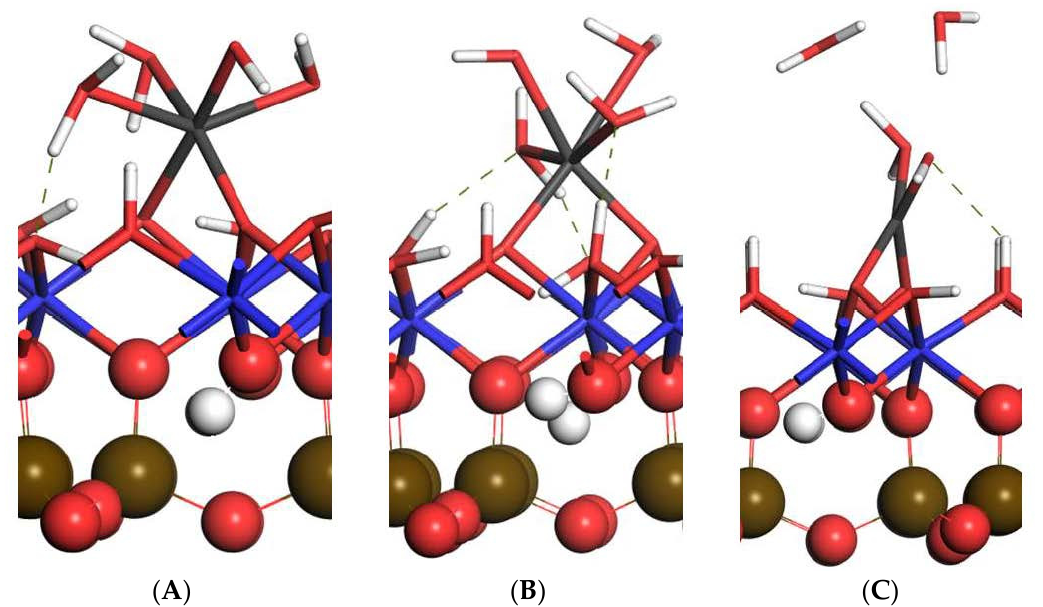
Figure 8. The bidentate adsorption structures of hydrated Fe(OH) 2+ at positions “O u ‐ O l ” ( A ), “O u ‐ O t ” ( B ), and “O t ‐ O l ” ( C ), respectively.